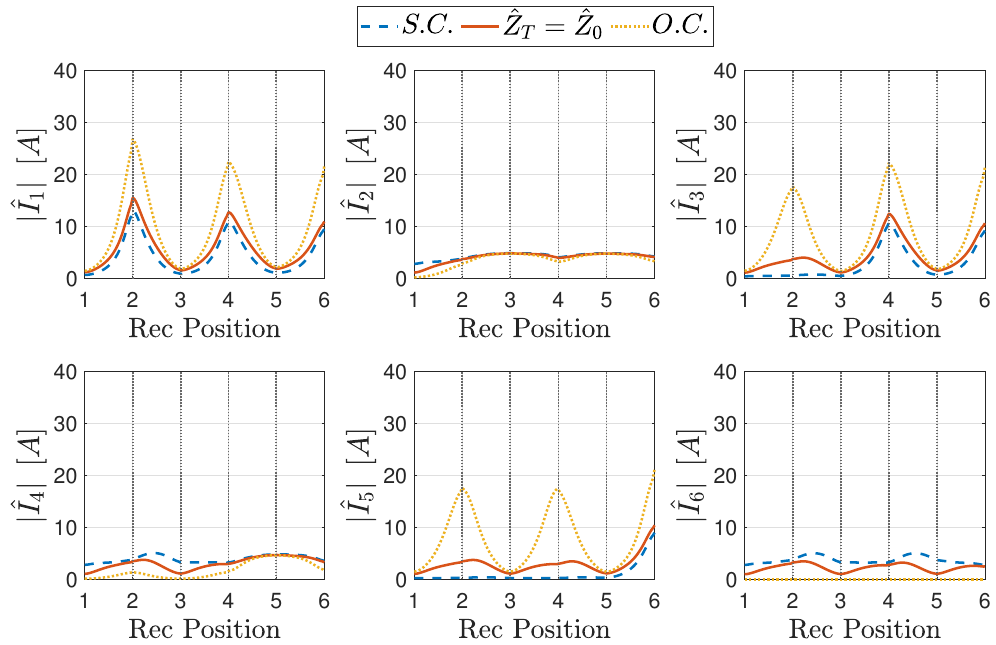
Figure 16. Magnitude of the currents of the array resonators as a function of the receiver position, for different terminations and a receiver load ˆ Z load = 5 Ω .